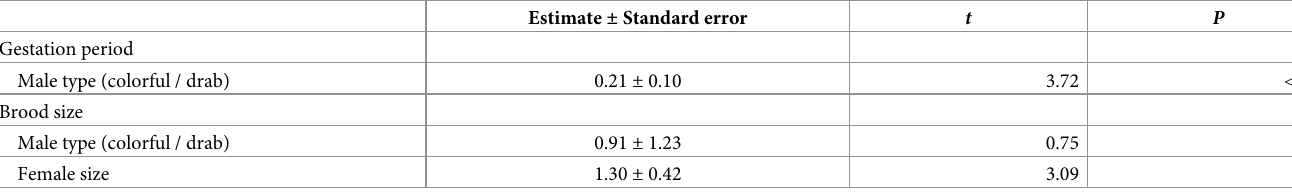
Table 1. Results of the generalized linear mixed model in parturition